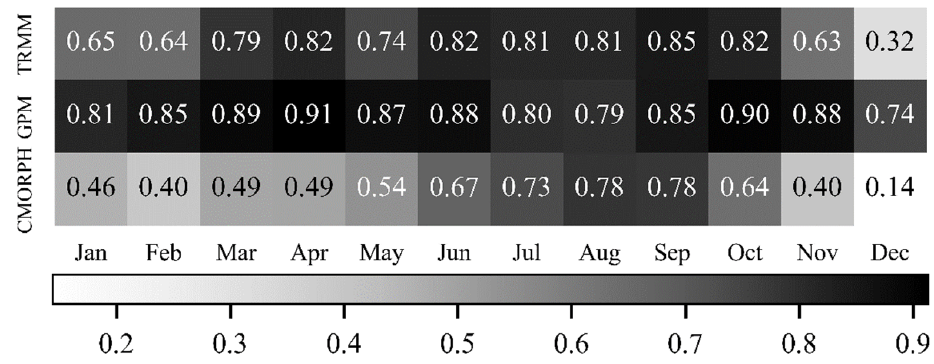
Figure 6. Correlation coefficient differences in each month among three remote sensing precipita- tion products.